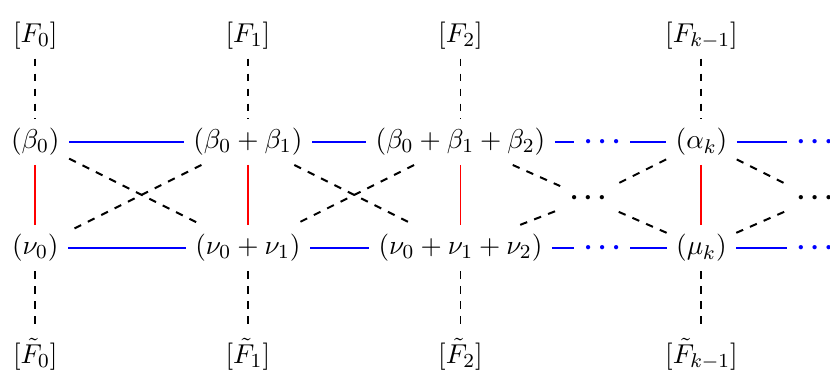
Figure 1 . The generic quiver whose IR is captured by the background in (2.1) and (2.2). Each gauge node is associated with a (4 , 4) vector multiplets. Blue lines represent (4 , 4) hypermultiplets. Red lines represent instead (0 , 4) hypermultiplets and dashed lines (0 , 2) Fermi